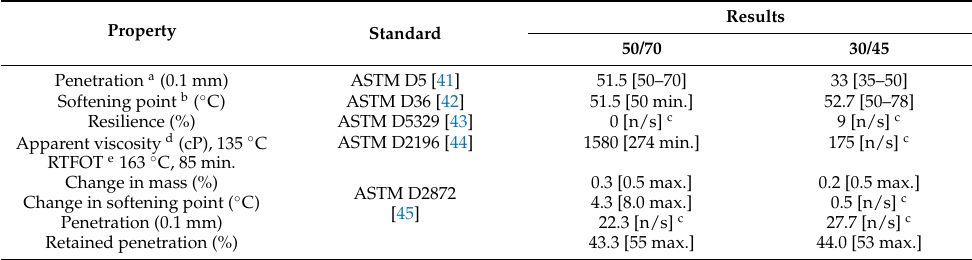
Table 3. Conventional asphalt base characterization.